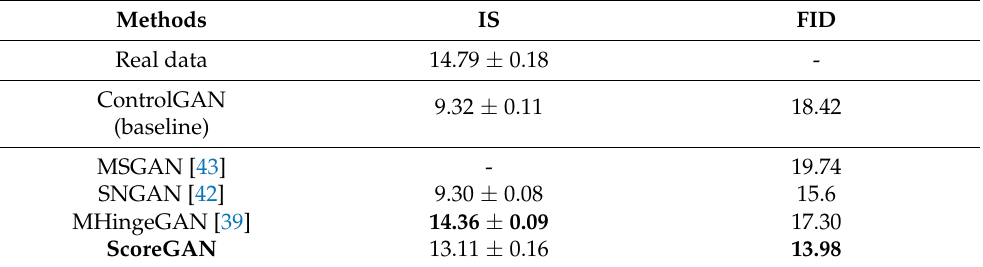
Table 4. Performance of the GAN models over the CIFAR-100 dataset. IS indicates the Inception score; FID indicates the Fréchet Inception distance. The best performances are highlighted in